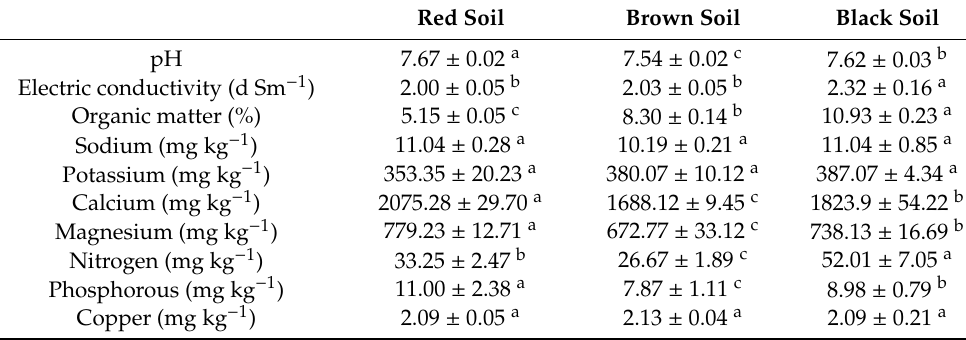
Table 1. Results of the physicochemical analysis evaluated to the three soils used for the cultivation of habanero pepper ( Capsicum chinense